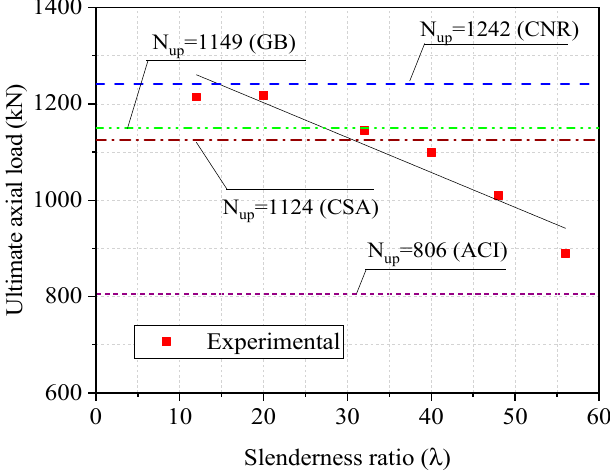
Figure 9. Comparison between the predicted values and experimental results.